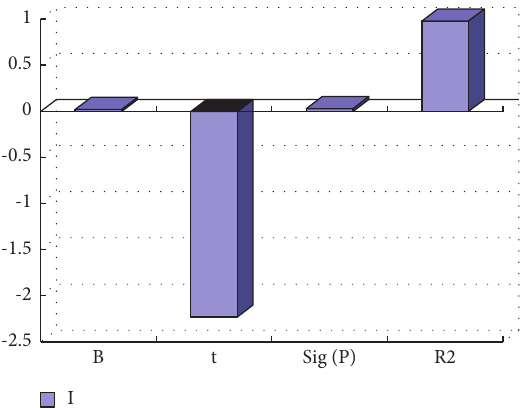
Figure 4: The regression model of plant background for